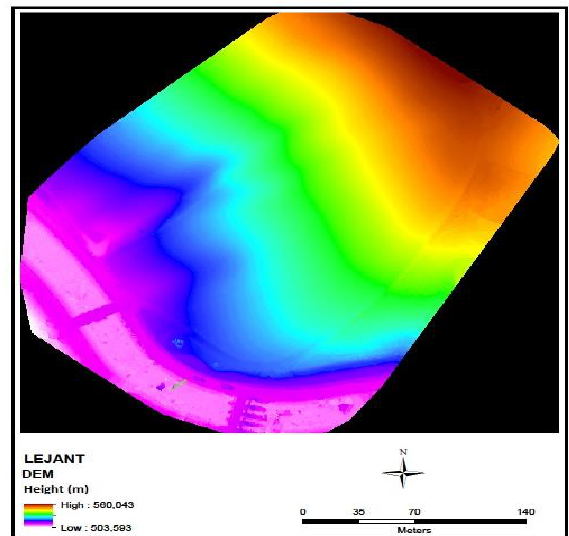
Figure 4. DEM of study area with high resolution generated orthophotos acquired by UAV